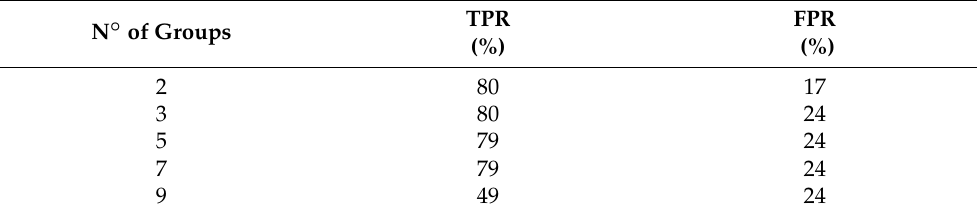
Table 8. Evaluation with metrics of the K-means method.